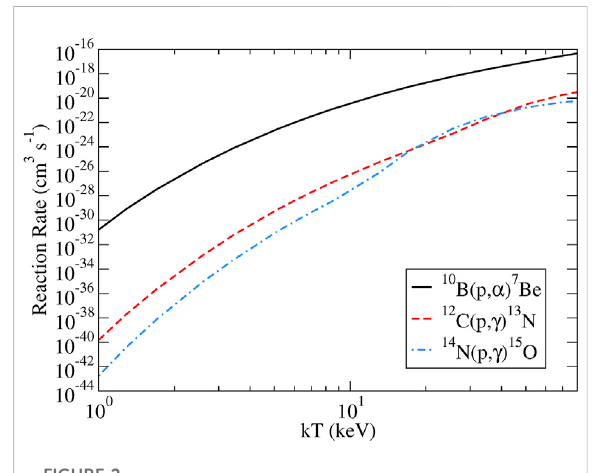
FIGURE 2 Reaction rates for the 10 B( p , α ) 7 Be (sold black line), 12 C( p , γ ) 13 N (dashed red line) and 14 N( p , γ ) 15 O (dashed-dotted blue line) reactions calculated from the R -matrix fi ts described throughout the remainder of the